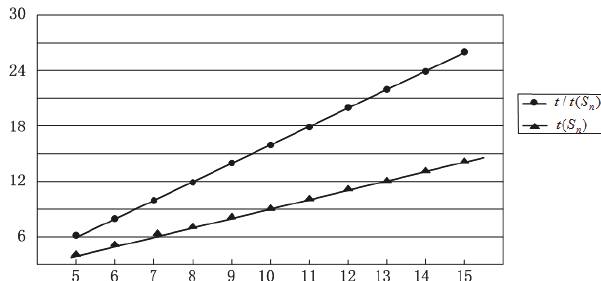
Figure 4: Comparison of classical diagnosability and 𝑡/𝑡 - diagnosability of 𝑛 -dimensional star